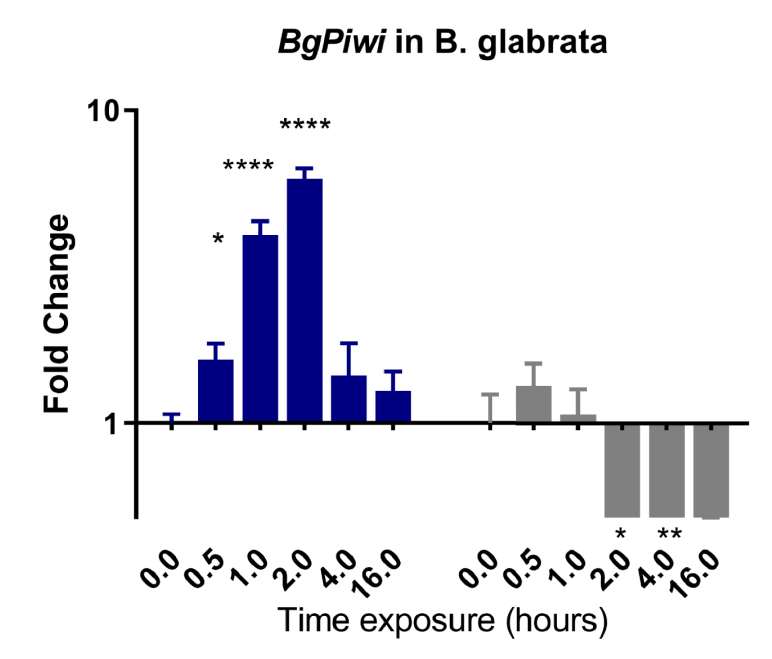
Fig 1. qPCR analysis of RNA from resistant BS-90 (blue histogram) or susceptible BBO2 (gray histograms) juvenile snails unexposed (0) or exposed for increasing intervals (30 seconds to 16 hours) to S . mansoni miracidia. Histograms show expression of the BgPiwi encoding transcript in snails at each time point from five biological replicates. Note the increase in fold change in the resistant BS-90 compared to the susceptible BBO2 snails after parasite infection. Significant expression normalized against expression of the myoglobin encoding transcript was measured by 2-way ANOVA and is indicated by number of asterisks on each histogram where ���� , indicates the most significant value p � 0.0001, ��� p � 0.001, �� p � 0.01, � p � 0.05, ns p > 0.05.